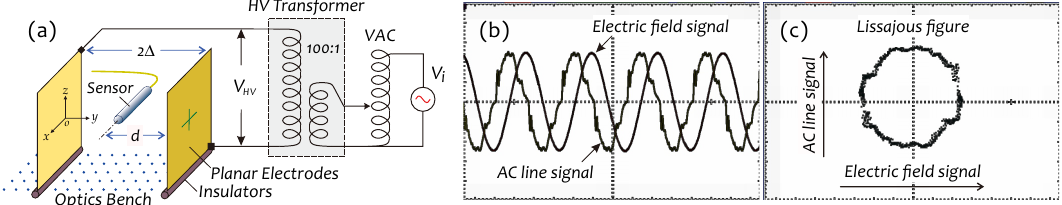
Figure 9. ( a ) Experimental setup for building an E -field environment. ( b ) E -field signal detected by our sensor and AC line signal detected by probe of oscilloscope, and ( c ) corresponding Lissajous